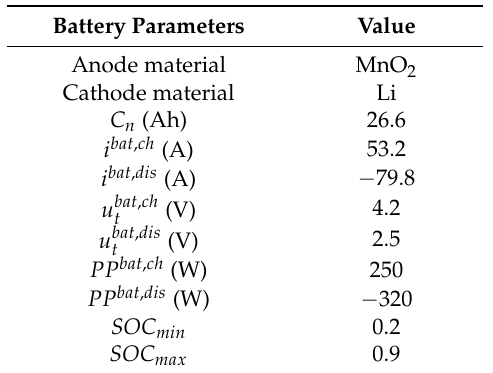
Table 1. The designed parameters of NCR18650PF battery.